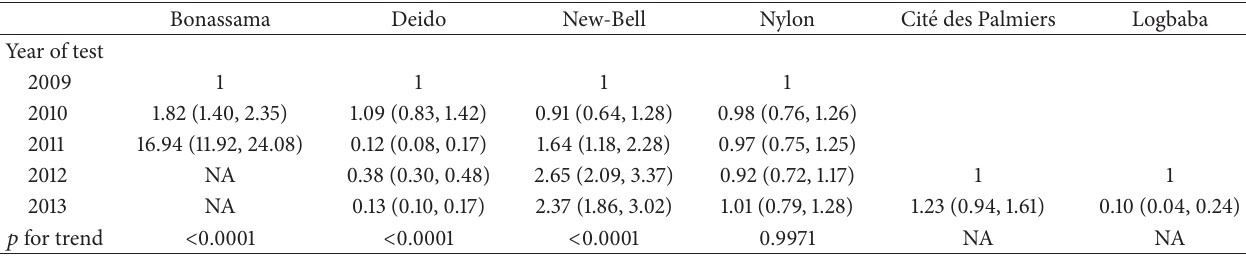
Table 4: Adjusted association between year of test and the likelihood for failure to return, by PVTCC †